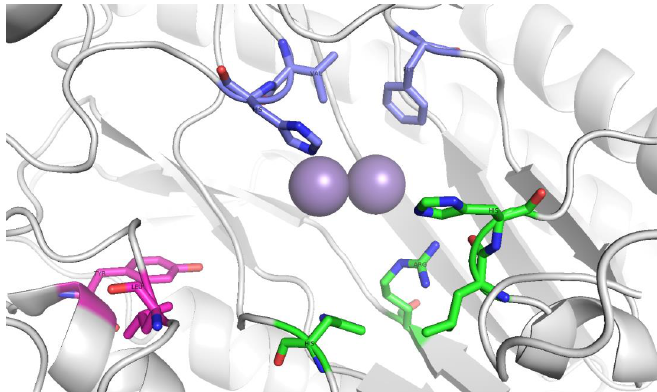
Figure 4. Organophosphate anhydrolase/prolidase from Alteromonas sp. (PDB ID 4ZWO, mutant Y212F, resolution 2.14 Å ) [88]: the large pocket formed by Leu225, His226, His332 and Arg418 (coloured green), the leaving group pocket formed by Tyr292 and Leu366 (coloured magenta), and the small pocket formed by Tyr212, Val342, His343, and Asp45 from the opposite chain (coloured